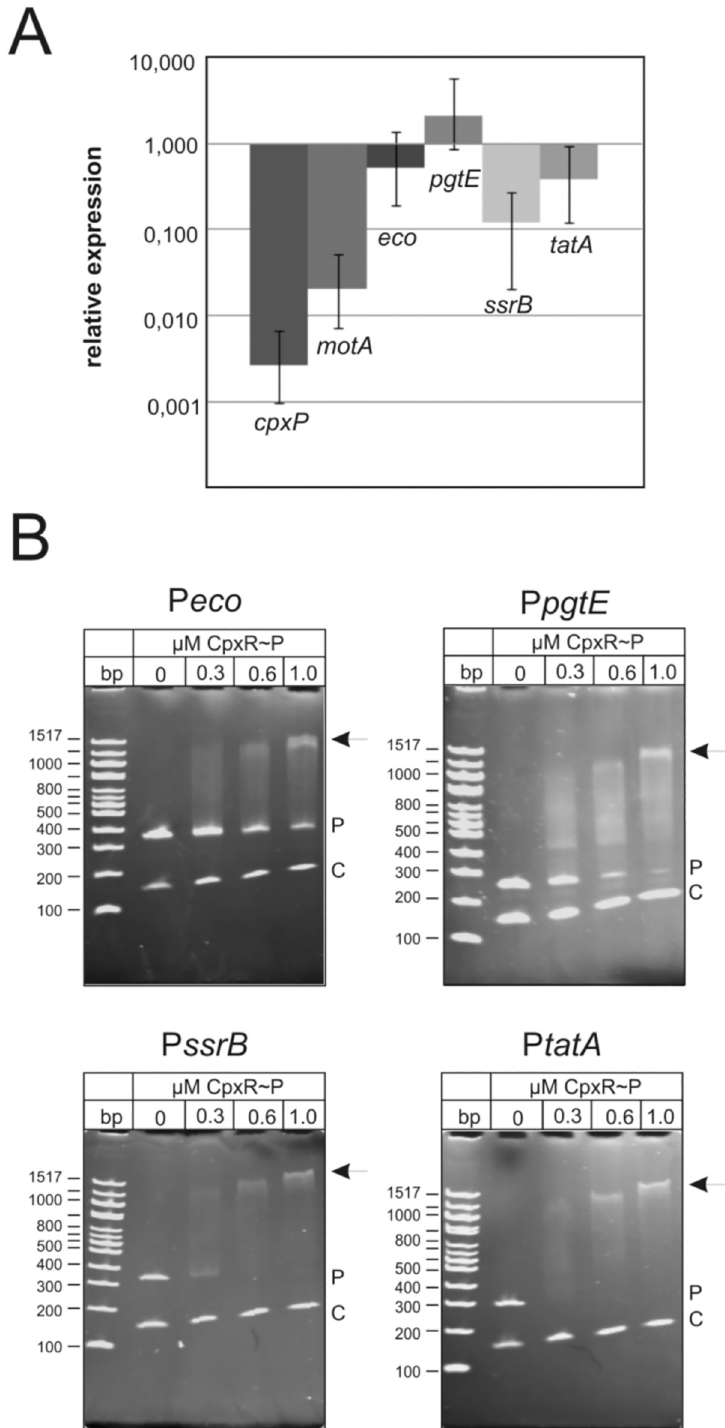
Fig 3. The Salmonella virulence determinants eco , pgtE , ssrB and tatA are under direct CpxR control. A. qRT-PCR analysis of CpxR target genes in the S. Typhimurium cpxR mutant NOS01. RNA samples were prepared from bacteria grown under invasion inducing conditions. In addition to the relative expression levels of cpxP and motA , the levels of eco , pgtE , ssrB and tatA were determined in NOS01 (sample) in comparison with the parental strain SL1344 (control) according to the formula ratio = 2 -[ Δ Ct, sample– Δ Ct, control] [43]. Columns indicate the mean values of one representative of biological triplicates together with the RQmin and RQmax. B. EMSA analysis verifies CpxR binding to the eco , pgtE